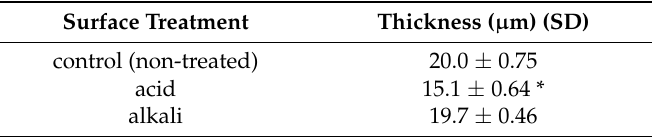
Table 1. Thickness of samples.